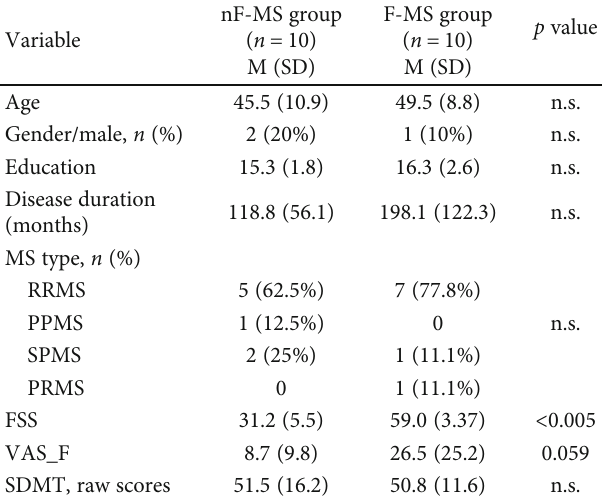
Table 1: Demographic and clinical information of the